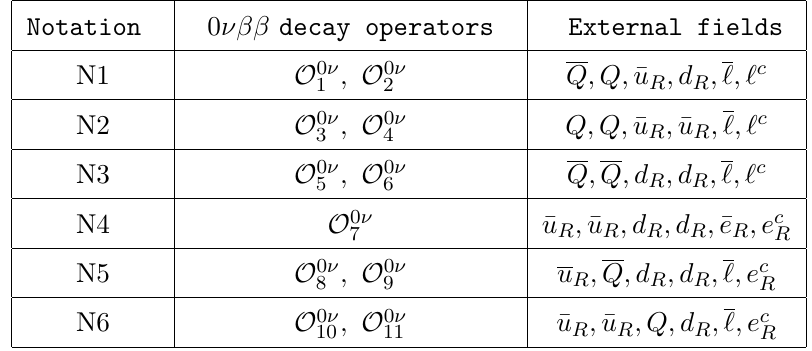
Table 1 . Summary of fields involved in the effective 0 νββ decay operators of dimension 9.